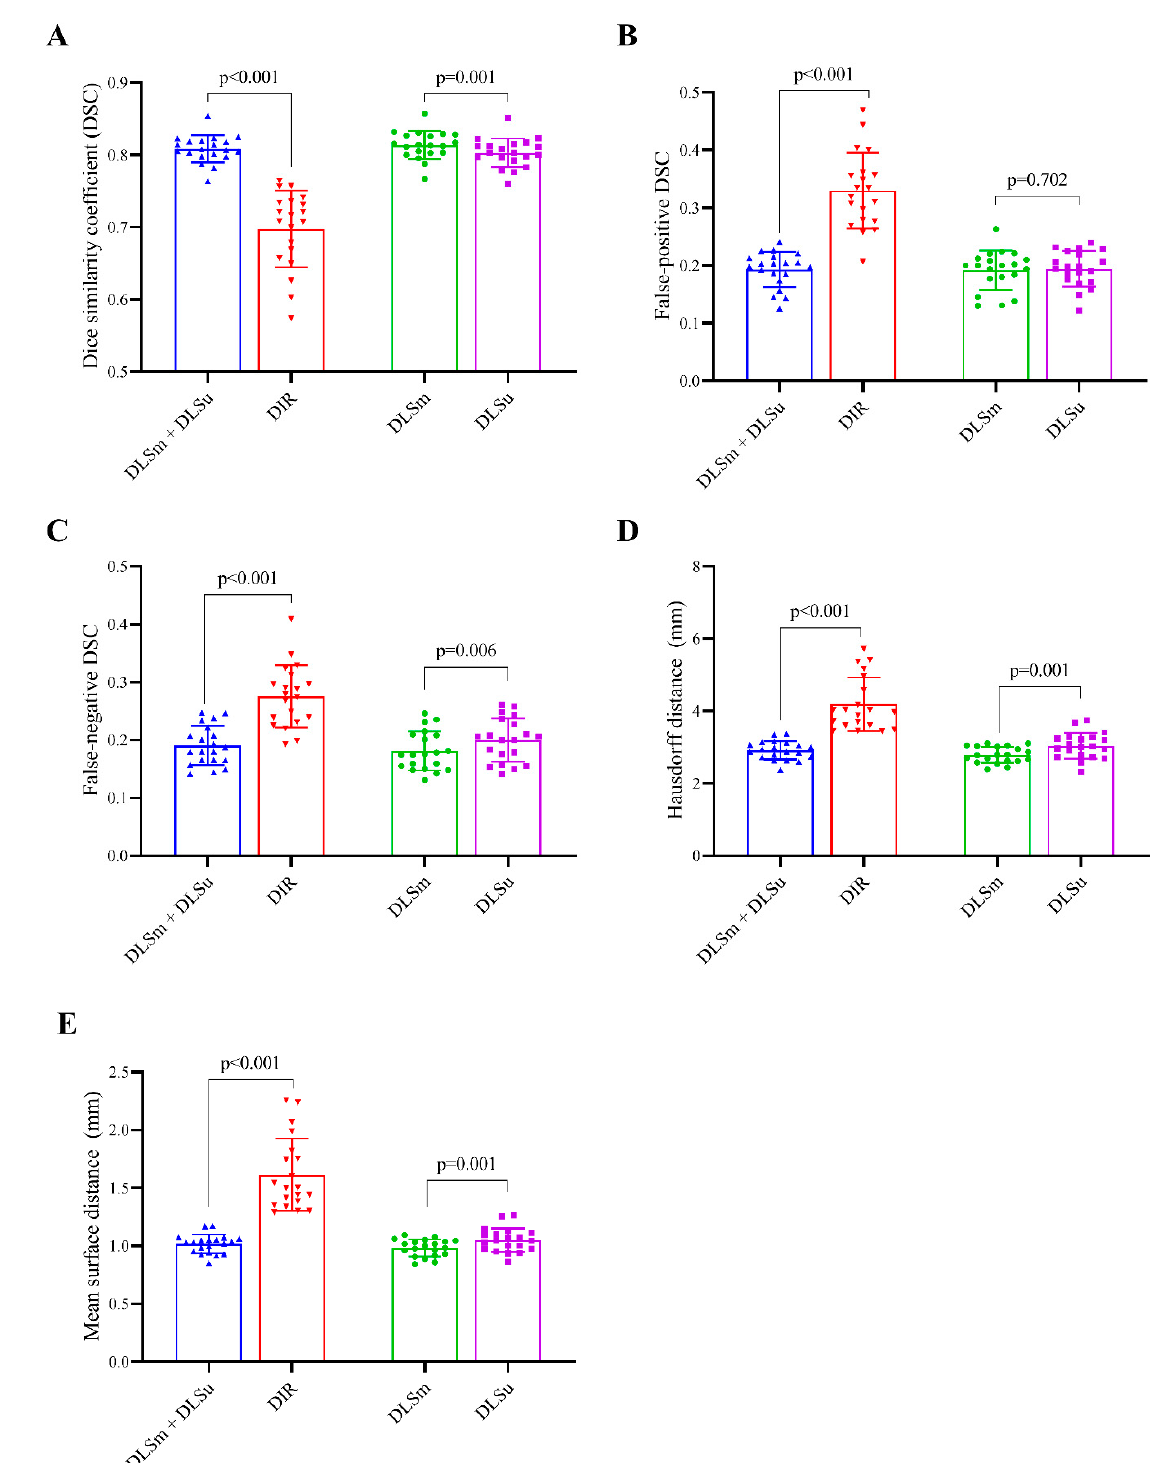
Figure 2. Examples of manual contour, deep learning-based segmentation based on the un- matched training set (DLSu) and matched training set (DLSm) and deformable image registration (DIR).